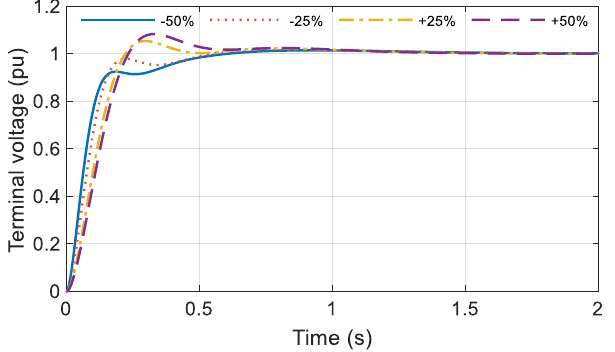
Figure 13. Step response under the variation of T A.